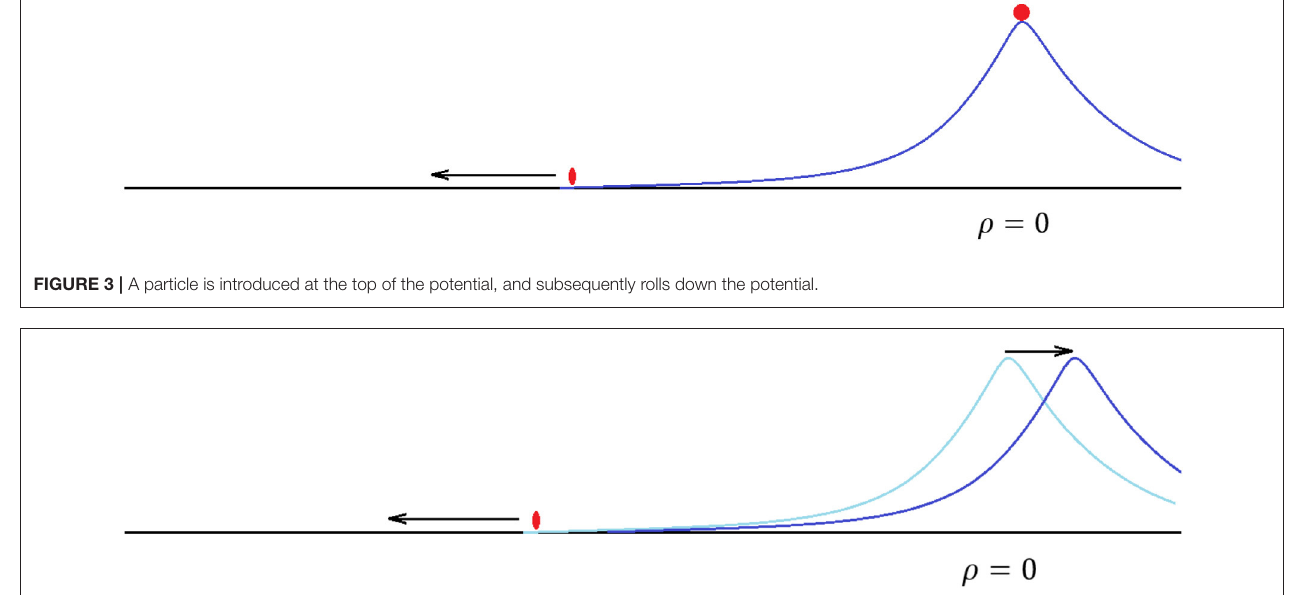
FIGURE 4 | The boundary recoils when the particle is accelerated. At all times the particle and the boundary have equal and opposite